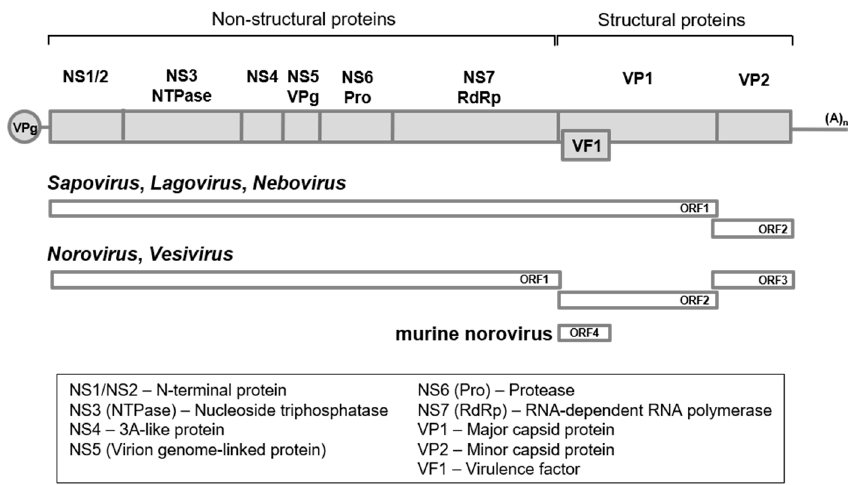
Figure 1. Diagrammatic representation of Caliciviridae genome. The 3 ′ end poly (A) tail and the 5 ′ end covalently linked virion protein genome-linked (VPg) depicted as (A) n and a gray circle, respectively. In sapo-, lago-, and neboviruses, open reading frame 1 (ORF1) and open reading frame 2 (ORF2) are used, whereas ORF1, ORF2 and ORF3, with an additional ORF4 for murine norovirus (MNV), are used in noro- and vesiviruses. Non-structural viral proteins are described below in a box.